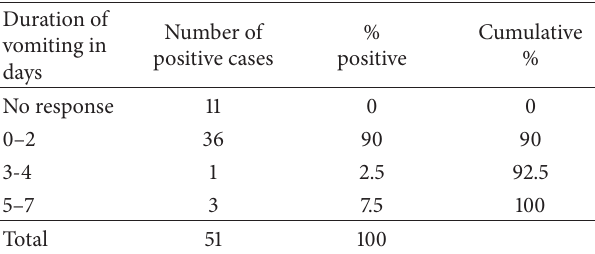
Table 3: Duration of vomiting in rotavirus diarrhoea in children in